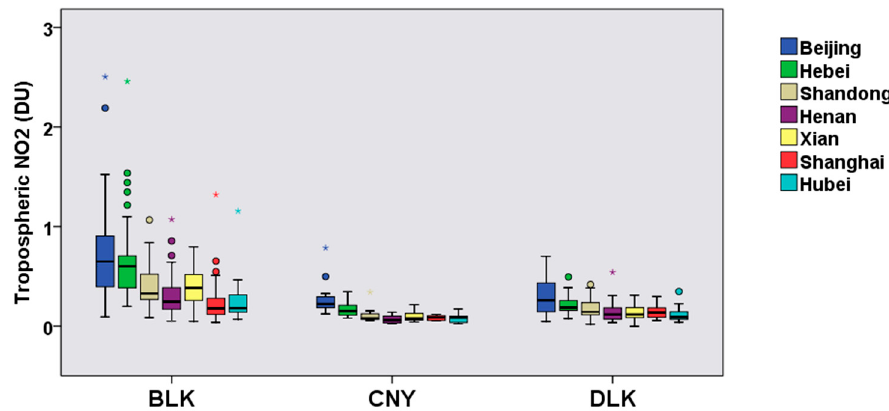
Figure 6. Daily mean satellite-derived tropospheric NO 2 over seven regions of China during the consecutive study periods of BLK, CNY and DLK in early 2020. The horizontal bar dividing each interquartile range (box) represents the median value. The upper and lower quartiles represent the 75th and 25th percentiles, respectively. The upper and lower whiskers represent maximum and minimum values, excluding outliers. Individual dots represent statistical outliers.